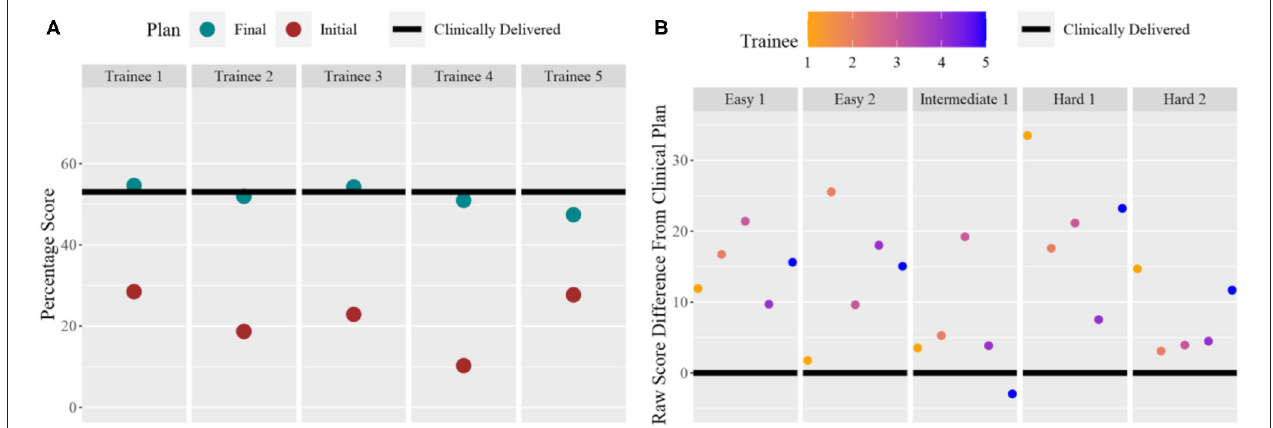
FIGURE 5 | (A) For each trainee (column), the total score for the benchmark case: pre-training plan (purple dot) and post-training plan (green dot) compared to the clinically delivered plan (black line). (B) For each training case (column), and for each trainee (color dots), the score difference between the trainee plan and the clinically delivered plan (black line indicating 0).